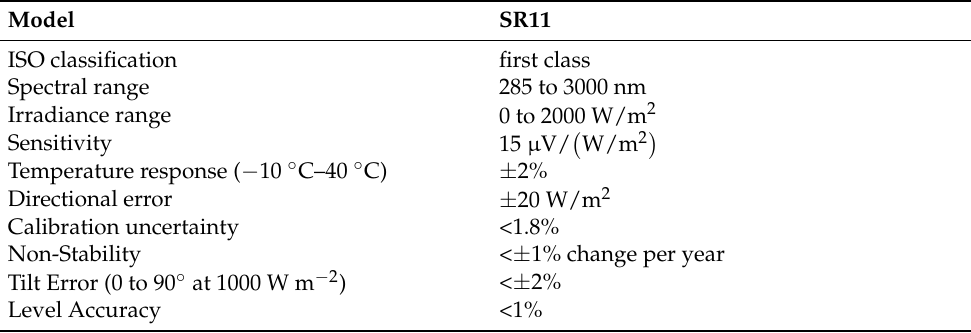
Table 3. Pyranometer technical